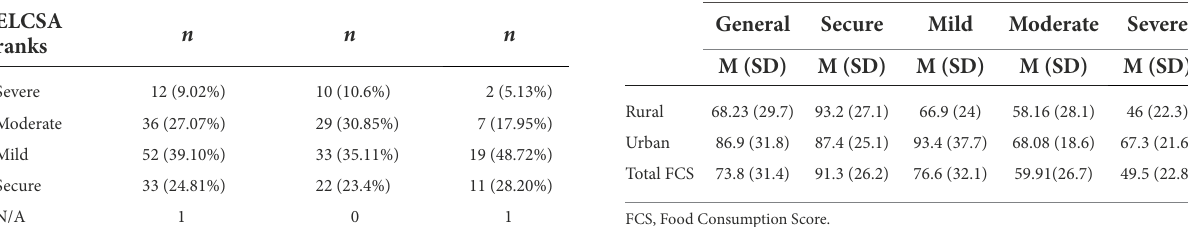
TABLE 3 ELCSA ranks by group. General